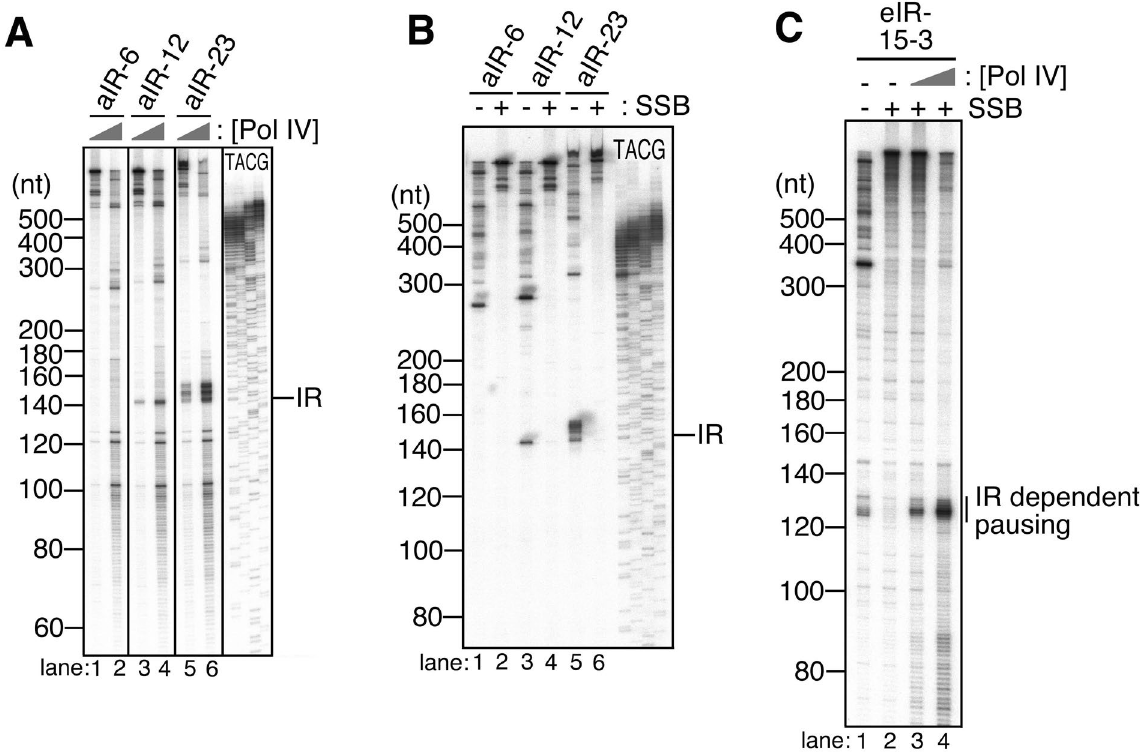
Figure 3. Pol IV-mediated Pol III pausing also occurs at inverted repeats with various length or sequence. ( A ) Template DNA carrying various sizes of inverted repeats, pMS2-aIR-6, -aIR-12 and -aIR-23 (6, 12, and 23 nt, respectively), were used for the assay to test the effect of Pol IV on Pol III. Wild-type Pol IV was added together with Pol III to the reaction at a final concentration of 10 and 100 nM (lanes 1–2, 3–4, and 5–6, respectively). After 3-minute pre-incubation, the elongation reactions were carried out for 10 seconds and replication products were analyzed as in Fig. 2B. 1-nt laddering markers representing sequences of pMS2-aIR-6 are shown on the right. ( B ) The behavior of Pol III HE in the presence or absence of SSB was analyzed on the DNA templates used in A. Laddering markers representing sequences of pMS2-aIR-12 are shown on the right. ( C ). The effect of Pol IV on Pol III was tested on a template carrying an E. coli endogenous inverted repeat (pMS2- eIR15-3) using wild-type Pol IV at a final concentration of 0, 10 and 100 nM as in A (lanes